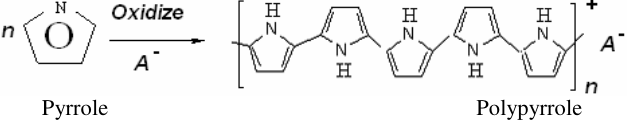
Figure 1. Overall polymerisation reaction of